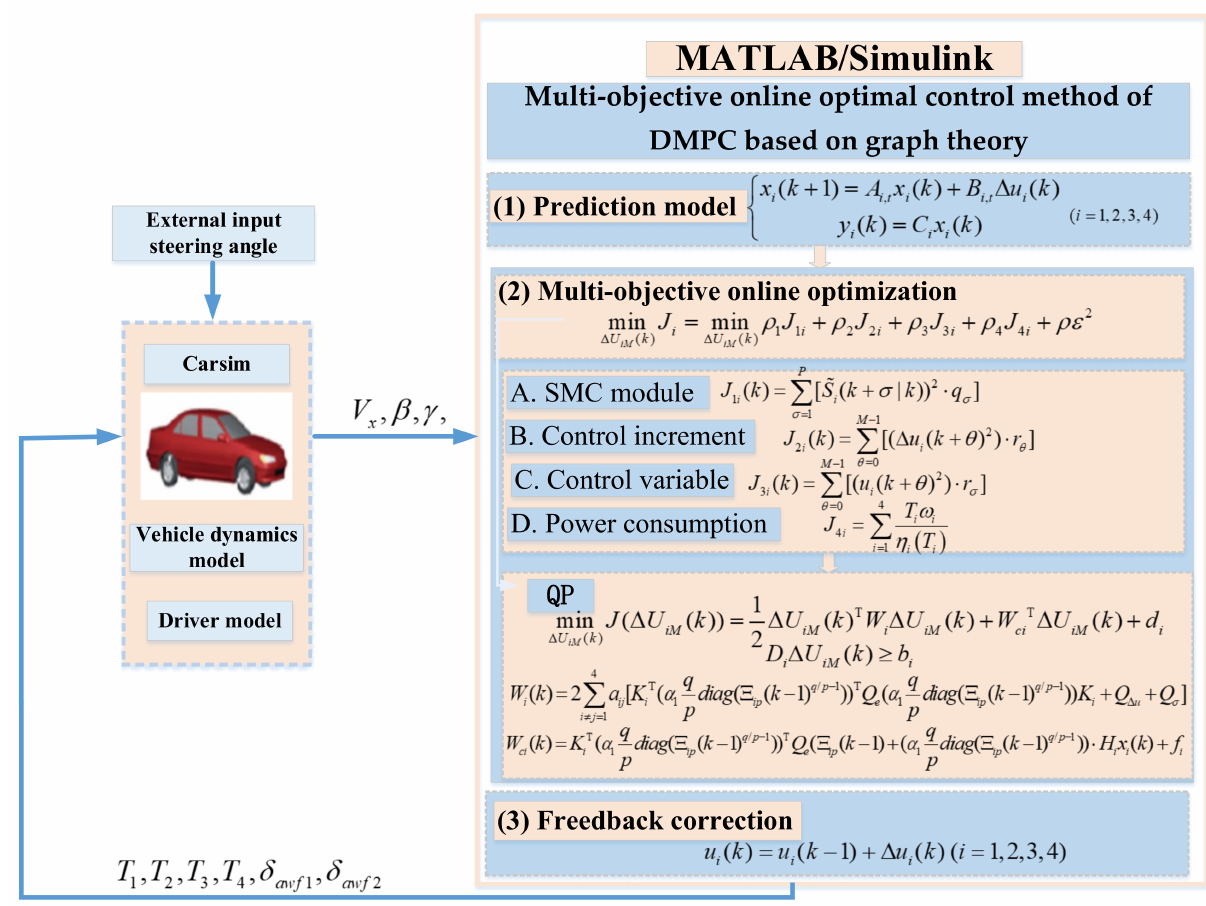
Figure 1. Overall structure of control